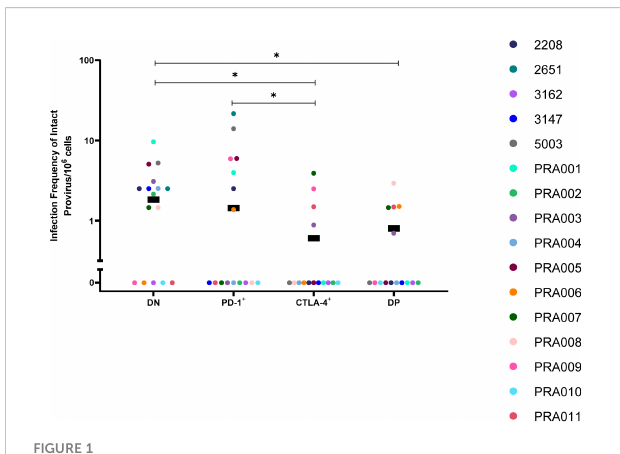
FIGURE 1 Genetically-intact HIV-1 proviruses in peripheral blood memory CD4 + T-cells expressing PD-1 and/or CTLA-4. The infection frequency per 10 6 cells of genetically-intact HIV-1 proviruses in DN, PD-1 + , CTLA-4 + and DP cells. Data is the estimated infection frequency per 10 6 cells for each subset. p-values represent evidence for an overall trend of a difference between subsets within these participants (mixed effects logistic regression), * p ≤